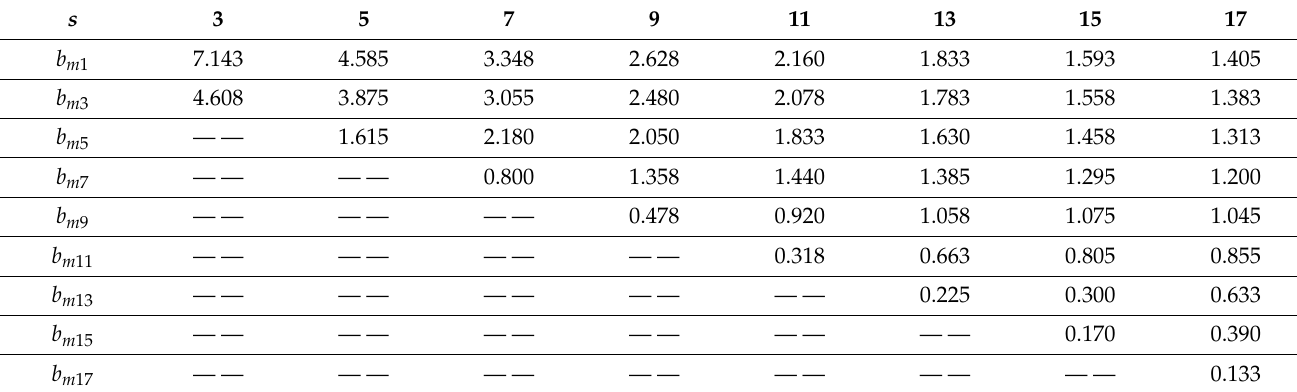
Table 4. Longitudinal lengths of PMs with an odd carrier